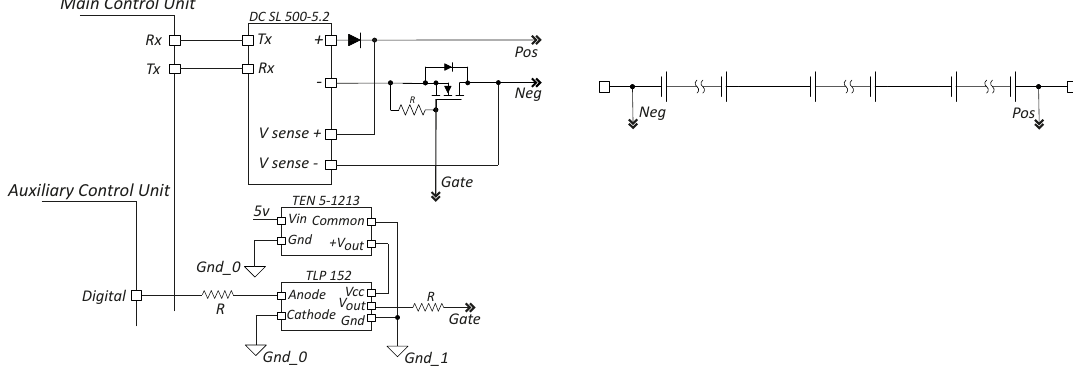
Figure 9. Power circuit command system.